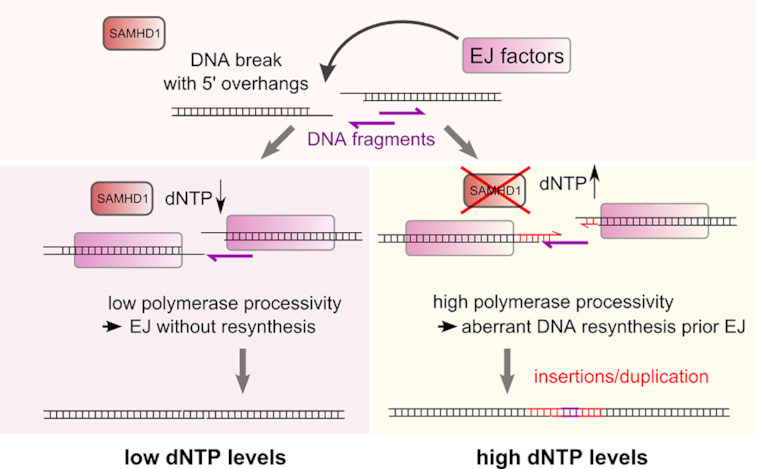
The dNTPase SAMHD1 keeps dNTP levels at moderate levels, incompatible with aberrant overhang resynthesis and insertions at DNA repair joints.